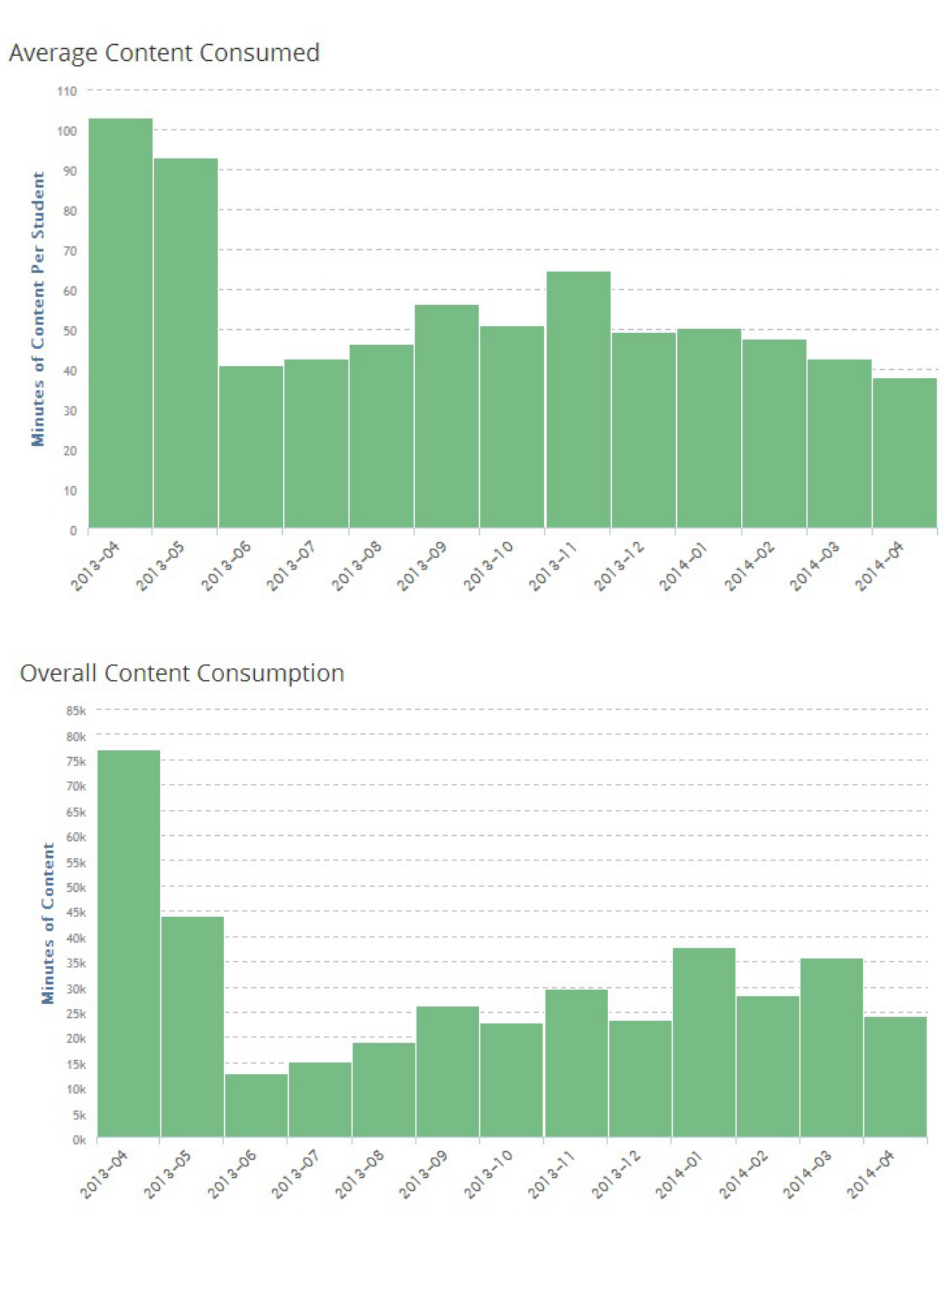
Figure 8. (a) Average content consumed per month of the Astronomy – State of the Art course. The early cohort consisting primary of amateur astronomers and educators had a higher level of engagement that all the cohorts that followed. The reason for the decline in the past six months is not clear. (b) Total content consumed, showing the high engagement of the early cohort, and then a continuing rise as the enrollment grows but with a lower typical level of